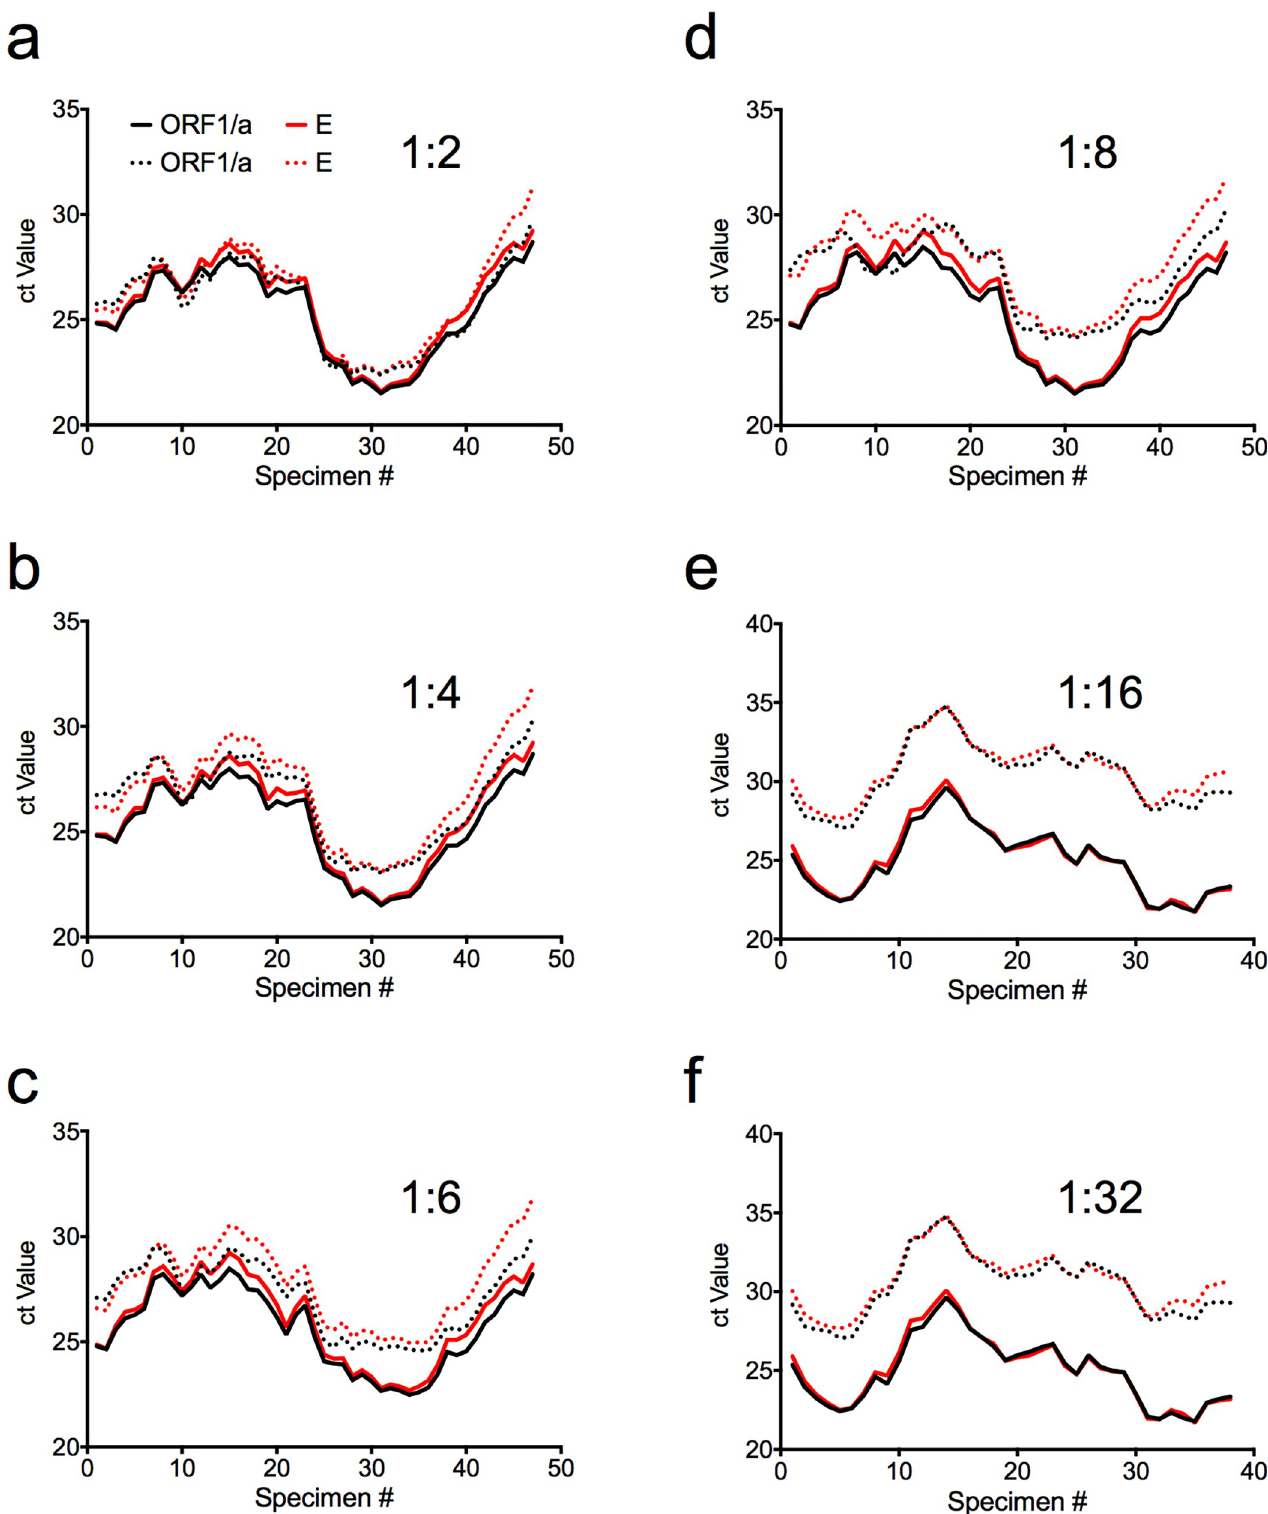
Fig 3. Change in Dorfman Pooled Ct values for each pool size. Individual unpooled Ct values are represented by solid lines, and pooled Ct values are graphed with dotted lines for each PCR target ORF1/a and E. Ct values are smoothed using an average of the nearest eight neighbours. A default Ct value of 40 was also instituted when pools had a result of “Target not detected” (Supplemental